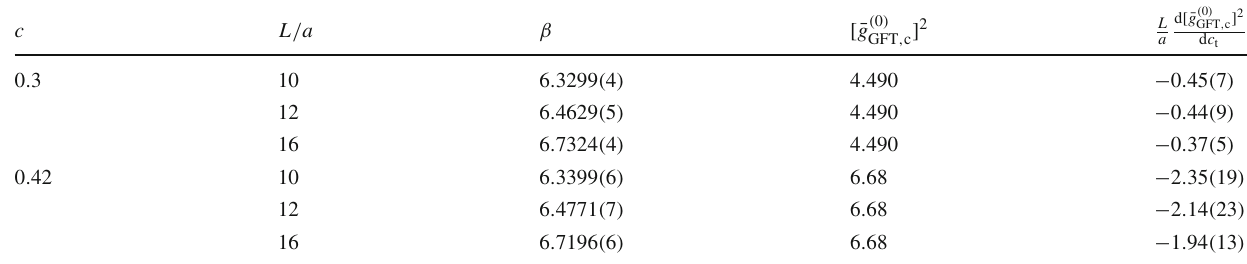
Table 7 Results of the interpolations Eq. (A.22) using the values in Table 5 and the target couplings, Eq. (A.21). (Note that we did not ( 0 ) ] 2 to the c propagate the error on [¯ g t -derivatives.) All fits have good GFT , c